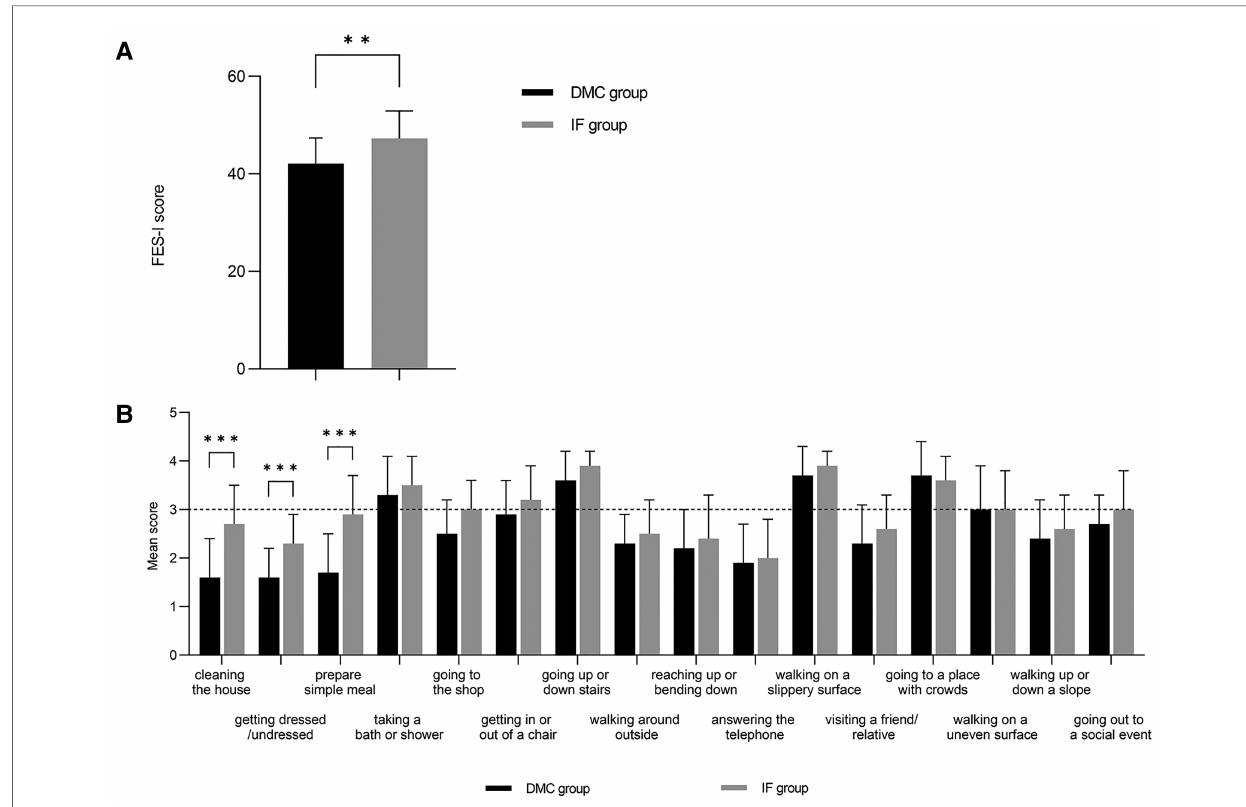
FIGURE 2 Scores for patient-related FOF assessed with the FES-I. The results of the DMC group cohort are shown in black and the IF group cohort are illustrated in grey. ( A ) Comparison of FES-I scores between DMC group and IF group. ( B ) Comparison between DMC group and IF group on subdimension scores of